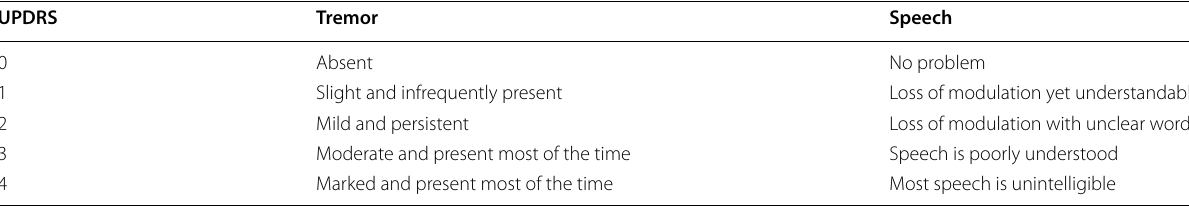
Table 2 Assigning UPDRS labels based on tremor and speech characteristics UPDRS